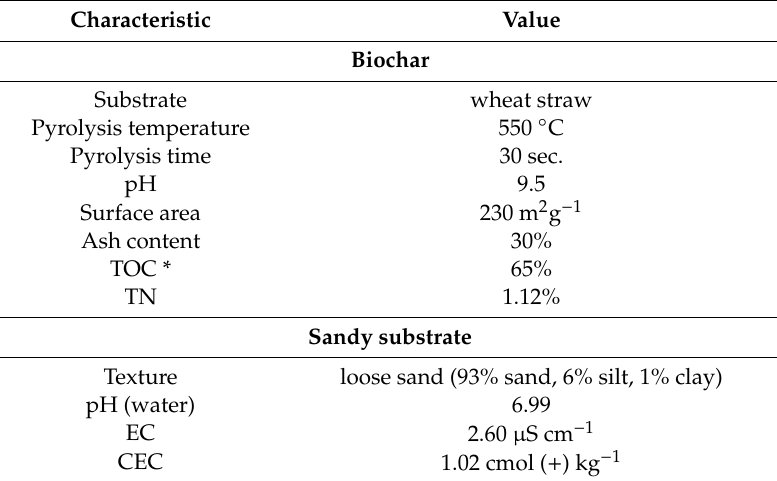
Table 1. Characteristics of biochar and sandy substrate used in